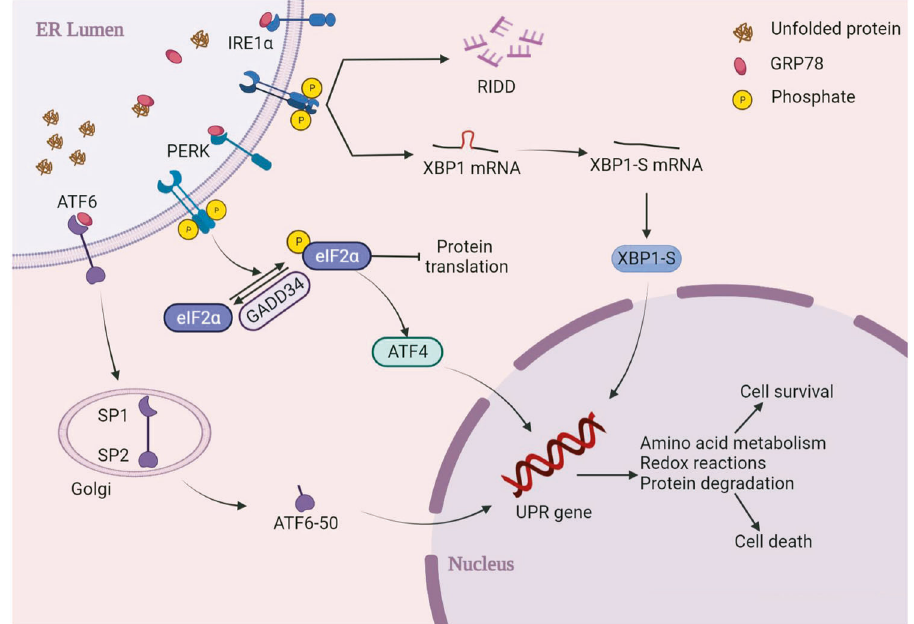
Fig. 1 Major pathway of UPR in mammals. Three transmembrane receptors, inositol-requiring enzyme 1 α (IRE1 α ), pancreatic endoplasmic reticulum kinase (PERK), and activating transcription factor 6 (ATF6), mediate endoplasmic reticulum stress (ERS) and unfolded protein response (UPR). It can act on the corresponding genes in the nucleus after activation through three pathways, triggering amino acid metabolism, redox reaction, and protein